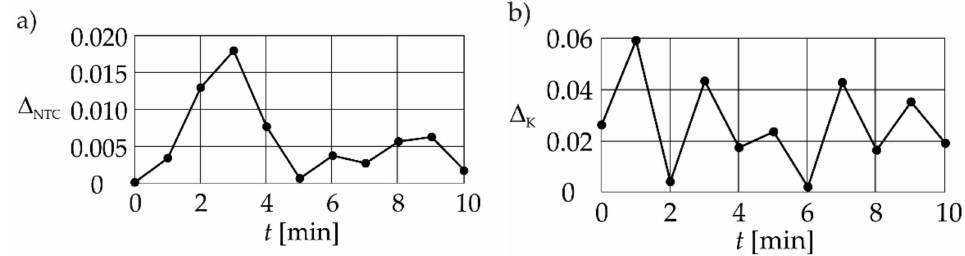
Figure 4. Distribution of the approximation error for both considered sensors: negative temperature coefficient (NTC) ( a ); K-type thermocouple ( b